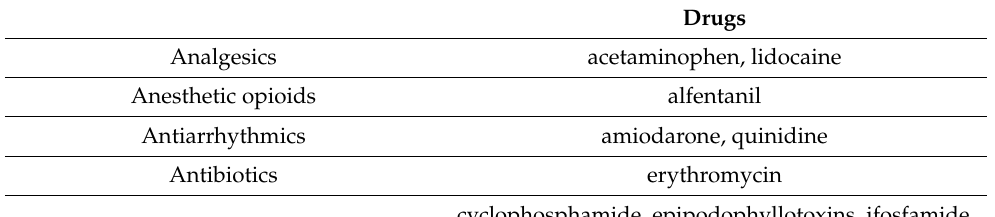
Table 2. Classes of drugs that are metabolized by CYP3A